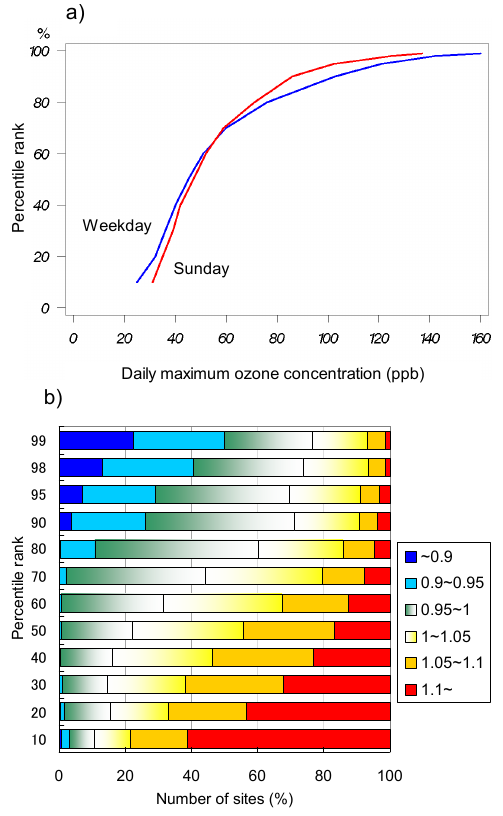
Fig. 2. (a) An example of cumulative frequency curves of daily maximum ozone concentrations for weekdays and Sundays, allow- ing comparison of values at the same percentile rank of O 3max . (b) Number of sites showing the ozone weekend effect, indicated by the ratio of the daily maximum concentration on Sundays to that on weekdays (colored scale), according to the percentile ranking of the ozone concentration. Total number of sites=899, with data avail- able for 1999–2004 from 36 prefectures in mainland Japan (Hon- shu) and Shikoku and Kyushu